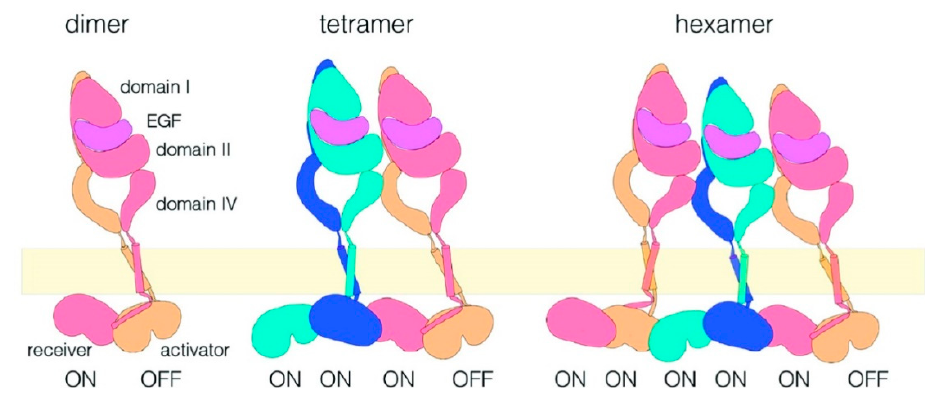
Figure 9. Model for EGFR oligomerization (figure adapted from Huang et al. (2016) [116]). The model is built from the known dimeric arrangements of the extracellular module, the transmembrane helices, and the kinase domains, and these have been connected to produce a model for dimeric full-length EGFR, as described [84,118]. The model for EGFR tetramers was obtained by packing the dimers against each other as rigid bodies. Repeating the interactions allows the building of higher-order oligomers such as